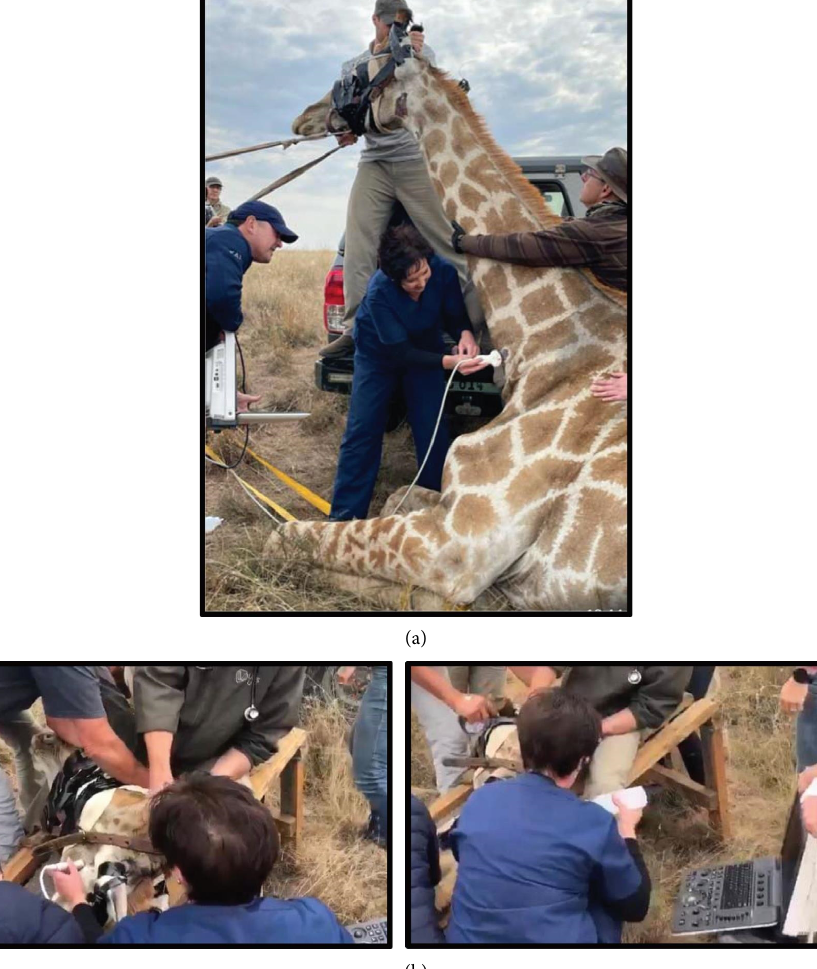
Figure 1: (a): Doppler waveform measurement in the head upright position. (b) Doppler waveform measurement in the head-down position.